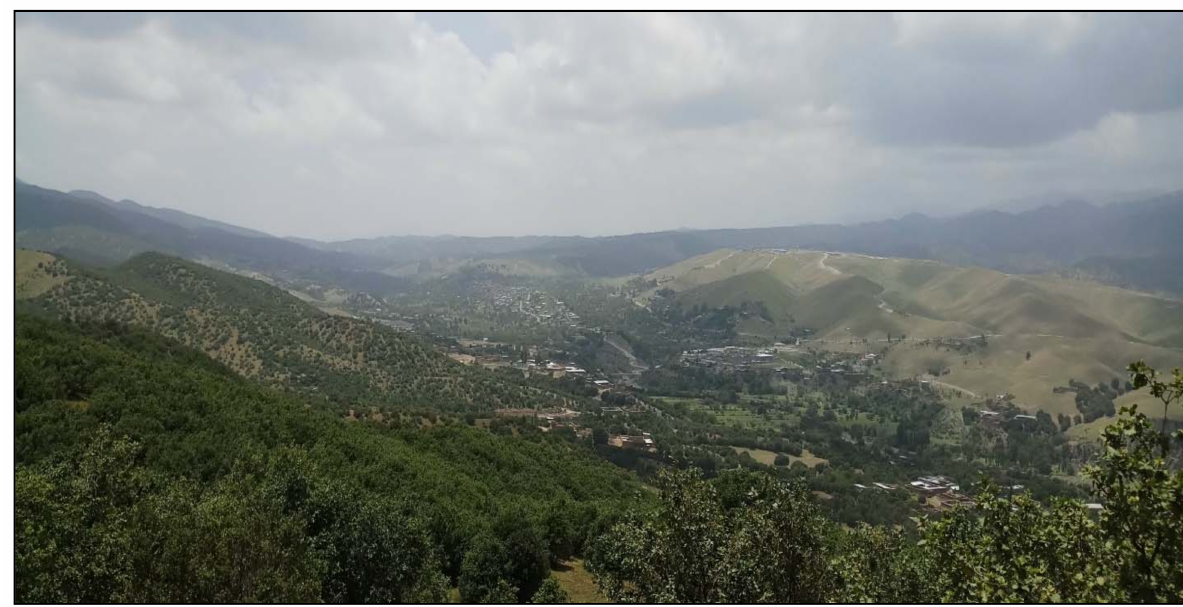
Figure 2. Landscape of the study